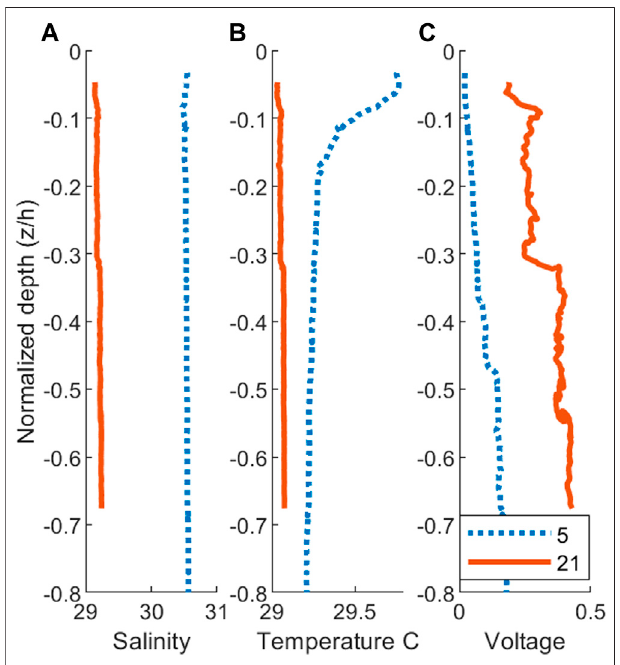
Voltage from CTD-Tu. Vertical axes represent the normalized depth (z/total waterdepth). CTD-Tupro fi les takendirectlybefore Transect #5(red lines)and during Transect #21 (blue dashed